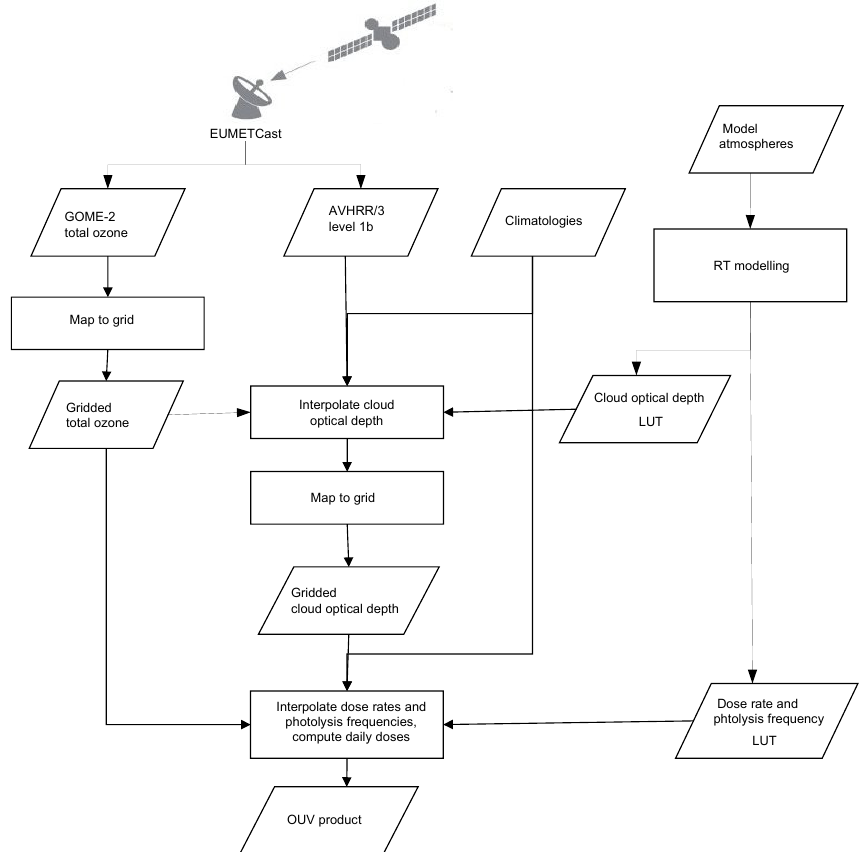
Figure 6. Overall processing algorithm. The radiative transfer modelling illustrated on the right side is performed offline and the results are stored in look-up tables (LUT). The input satellite data are received from the EUMETCast system. The GOME-2 total column ozone product is mapped to the processing grid and then used together with the climatologies in both deriving the intermediate cloud optical depths from the AVHRR/3 level 1b data and interpolating the output products from the look-up